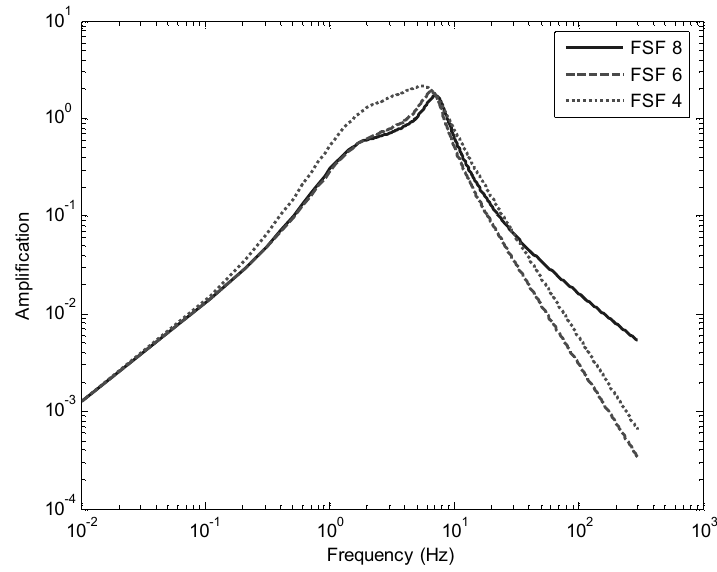
Fig. 11. Angular acceleration for right road